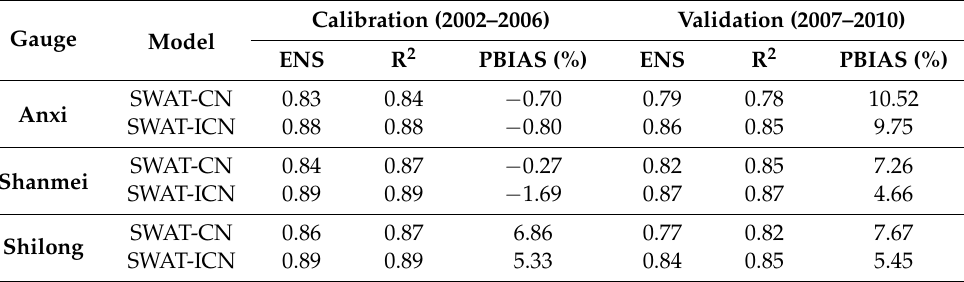
Table 3. Performance measures of SWAT-ICN and SWAT-CN in Anxi, Shanmei, and Shilong watersheds for calibration and validation